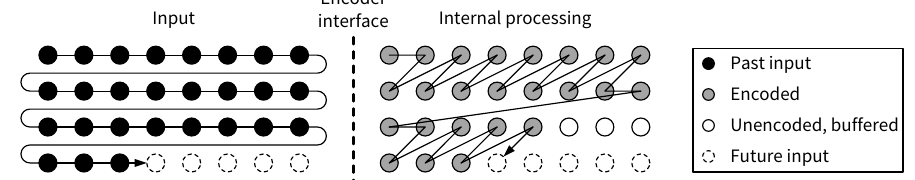
Figure 18. Input pixel scan order (raster scan) vs. internal pixel processing order (skewed scan [14]).